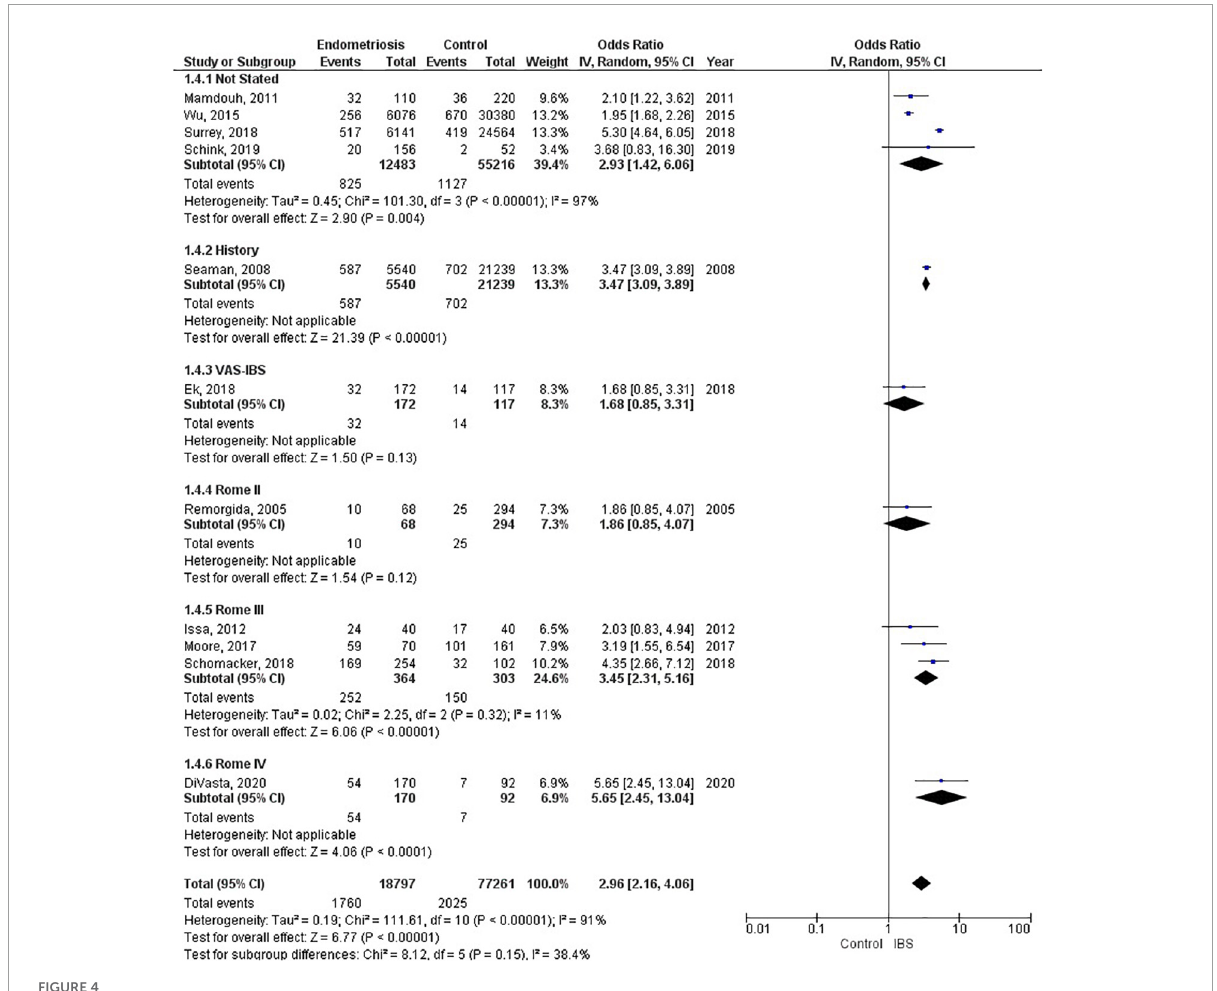
FIGURE4 Forest plot by IBS